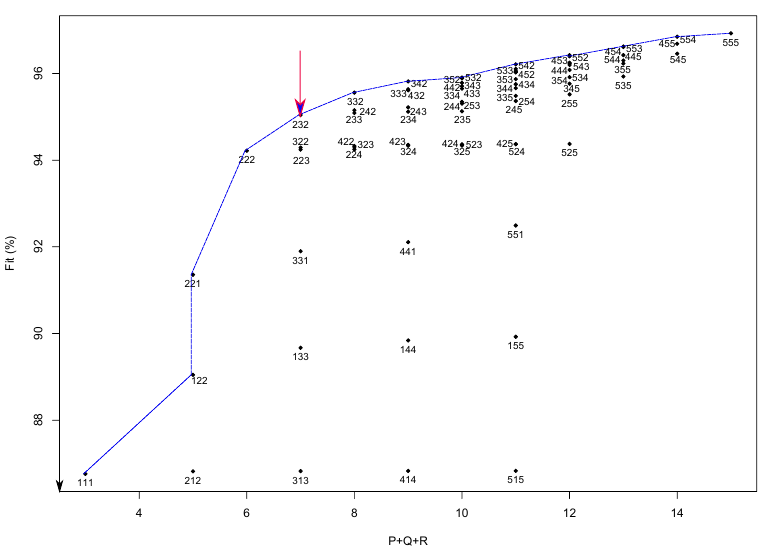
Figure 6. Plot of the T3 solutions for different values of P, Q, and R. The rotational indeterminacy was used to reach the maximal simplicity for the core tensor and the component matrices in order to facilitate interpretation of the solution. The post-processed component matrices for timetable and days are given in Tables 3 and 4. The post-processed core array is presented in Table 5. Note that the core array is presented as a matrix where rows represent the stations components and columns represent the